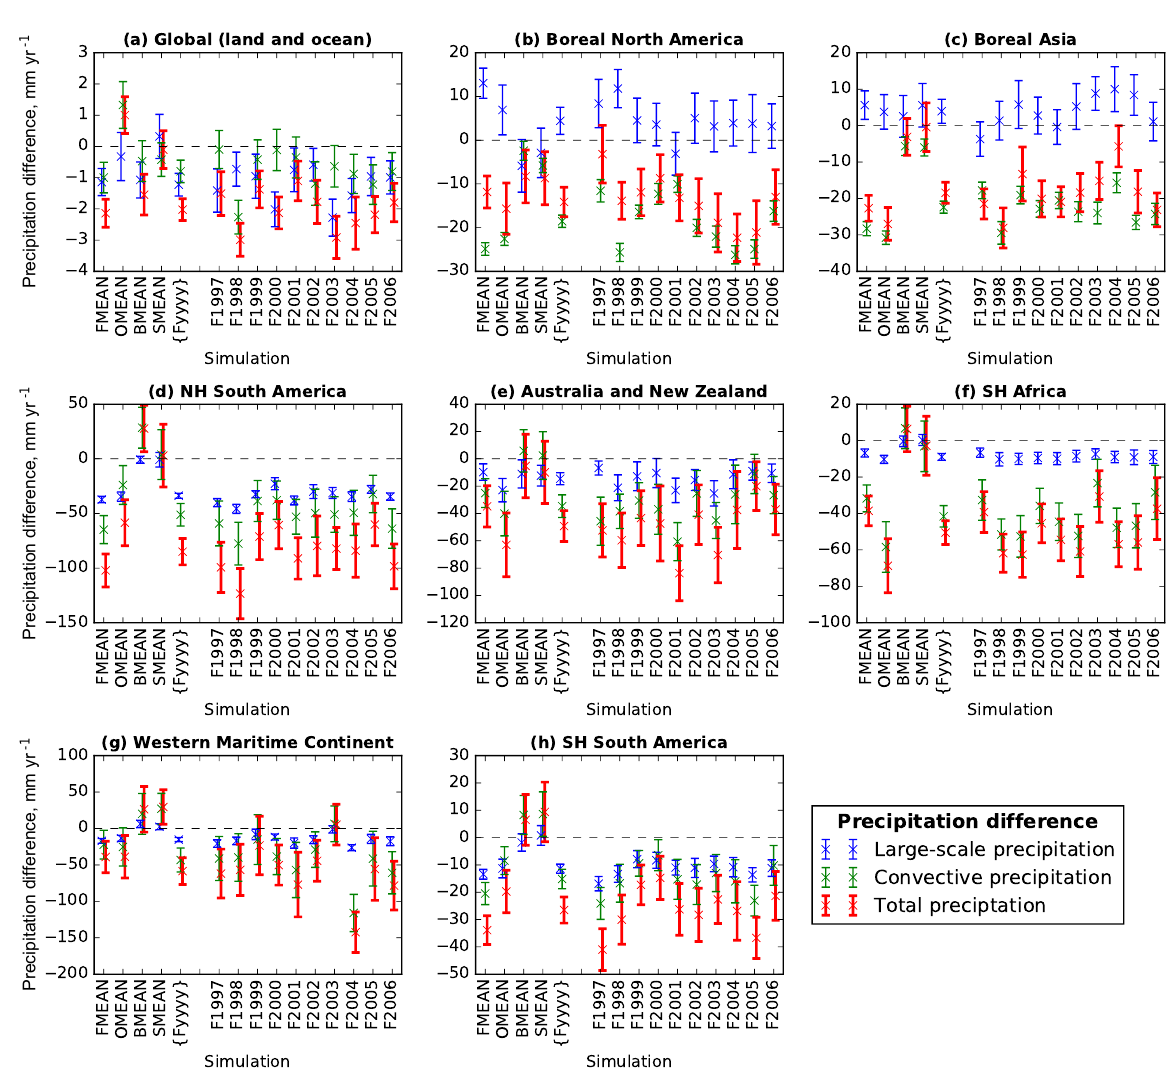
Figure 7. Large-scale, convective, and total (large-scale plus convective) annual precipitation differences, relative to simulation F0, for the globe and seven regions. Error bars represent combined standard error. Results for another eight regions are shown in Fig.